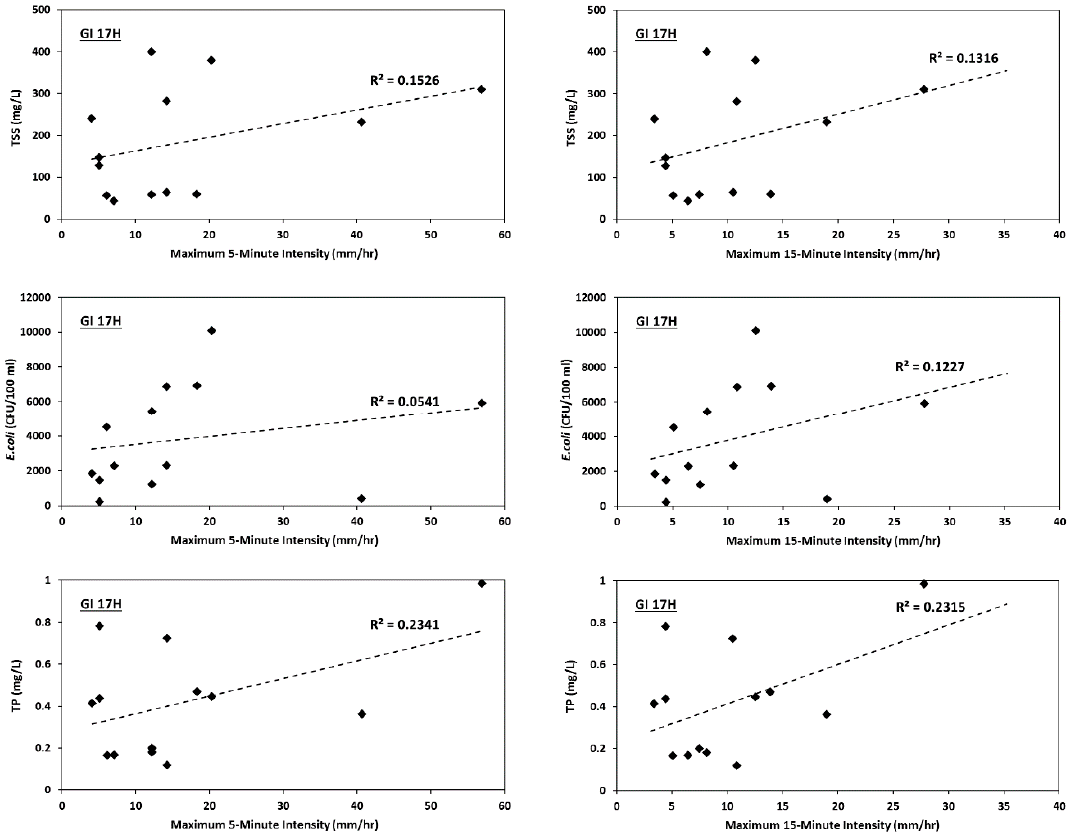
Figure 8. TSS, E. coli , and TP concentrations in the runoff versus maximum 5-min and 15-min intensity values in GI 17H.